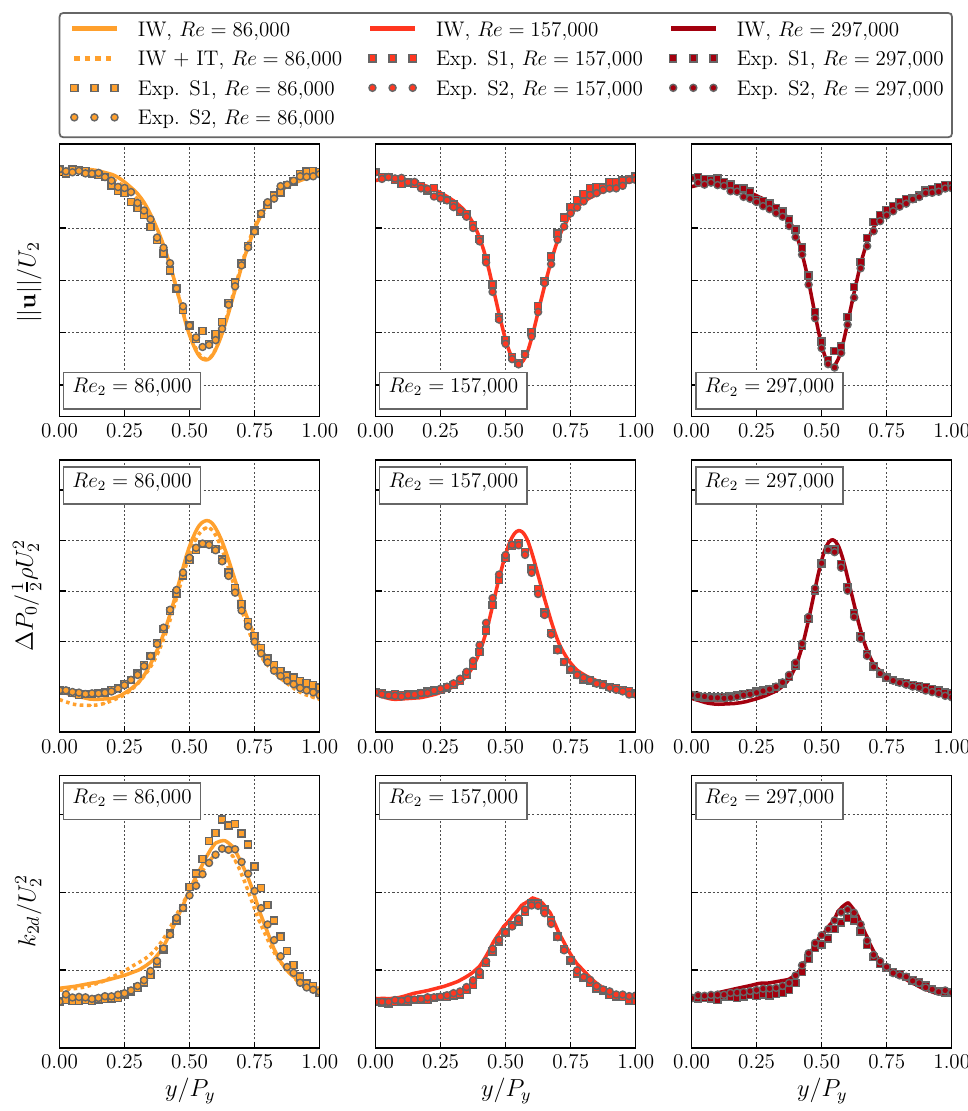
Figure 7. Wake traverses at ˆ x = 0.513 with increasing Reynolds numbers. ( Left ): Re 2 = 86,000 (in yellow); ( middle ): Re 2 = 157,000 (in red); ( right ): Re 2 = 297,000 (in burgundy). Three differ- ent wake profiles are shown. ( Top ): velocity magnitude; ( middle ): total pressure loss coefficient; ( bottom ): turbulence kinetic energy. The solid lines indicate IW simulations, and the dashed line indicates IW+IT, for Re 2 = 86,000 only. The two experimental traverses S 1 and S 2 are represented with squares and circles. Y -axis tick labels are omitted due to data